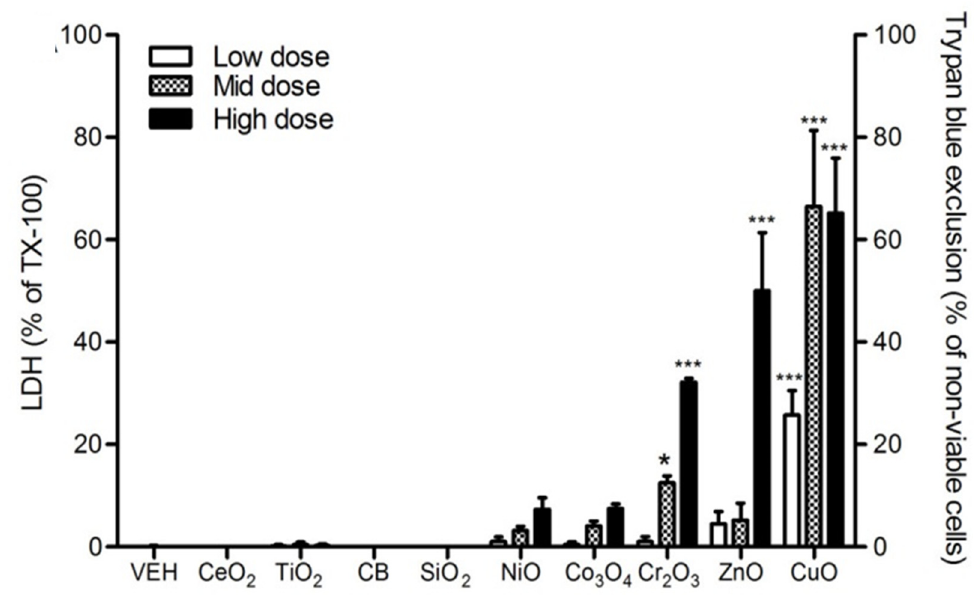
Figure 5. Cytotoxicity of several metal oxide nanoparticles on A549 cells after 24 h of nanoparticle treatment. Cytotoxicity was assayed by trypan blue exclusion for ZnO and CuO nanoparticles. Other particles were assayed by lactate dehydrogenase (LDH). The surface area doses were 30, 100, and 300 cm 2 /mL for all nanoparticles, with exception of CuO and ZnO nanoparticles, which were 3, 10, and 30 cm 2 /mL. Values are mean ± SD from a minimum of four independent experiments. Significance versus vehicle control (VEH): * p < 0.05, *** p < 0.001. CB = Carbon back. Reproduced from reference 126 with permission of the BioMed Central